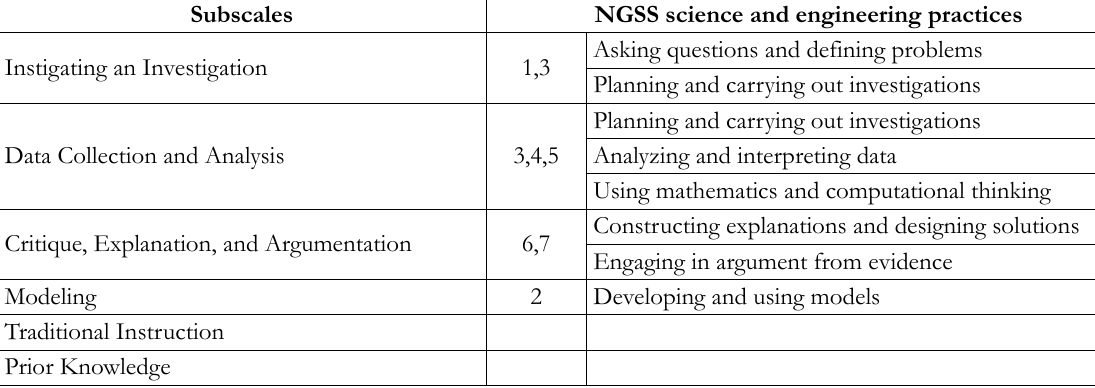
Table 3. Areas of instructional practice and the alignment with the NGSS science and engineering practices